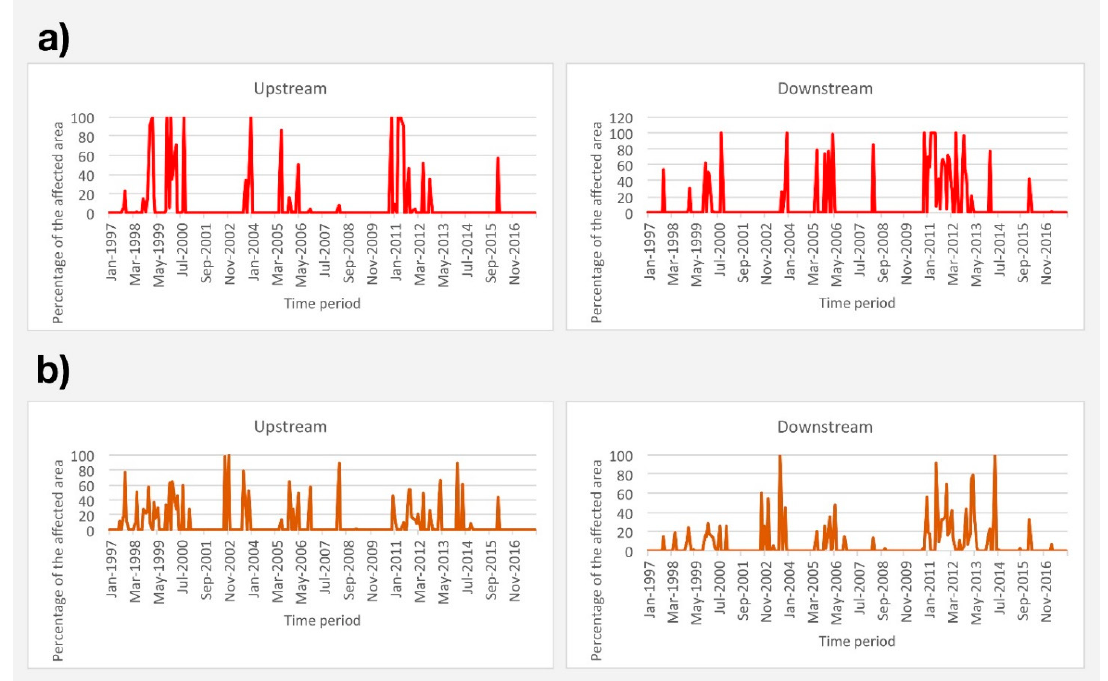
Figure 3. Percentage of the upstream and downstream area affected by ( a ) exceptional and ( b ) extreme drought, from 1997 to 2017. Information obtained from the National Water Commission (CONAGUA) and the National Autonomous University of Mexico (UNAM), [62].